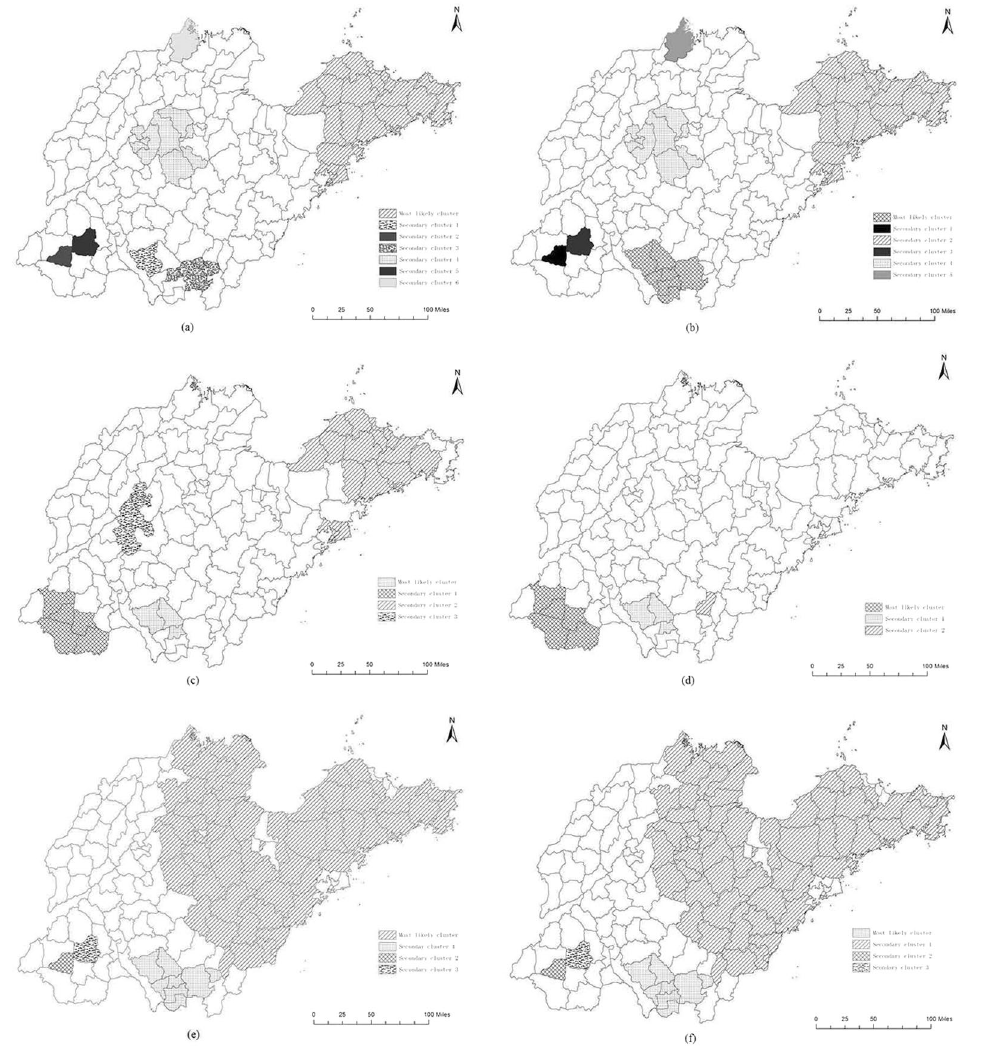
Figure 3. Female breast cancer mortality clusters at the county level in Shandong for the years 2011 to 2013 using the spatial scan statistical analysis ( a ) Total without adjustment; ( b ) Total adjusted for age; ( c ) Urban without adjustment; ( d ) Urban adjusted for age; ( e ) Rural without adjustment; ( f ) Rural adjusted for age (ArcGis 10.2